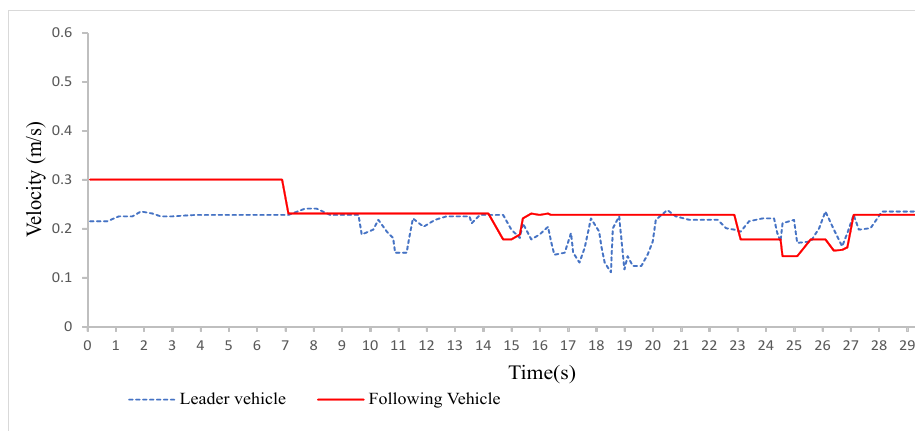
Figure 5. Velocity of leader vehicle and followers vehicle.